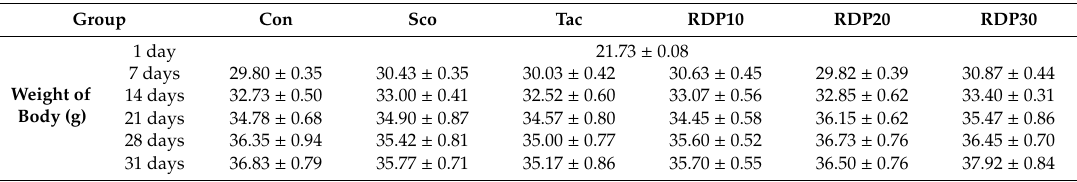
Table 1. Body weight of the